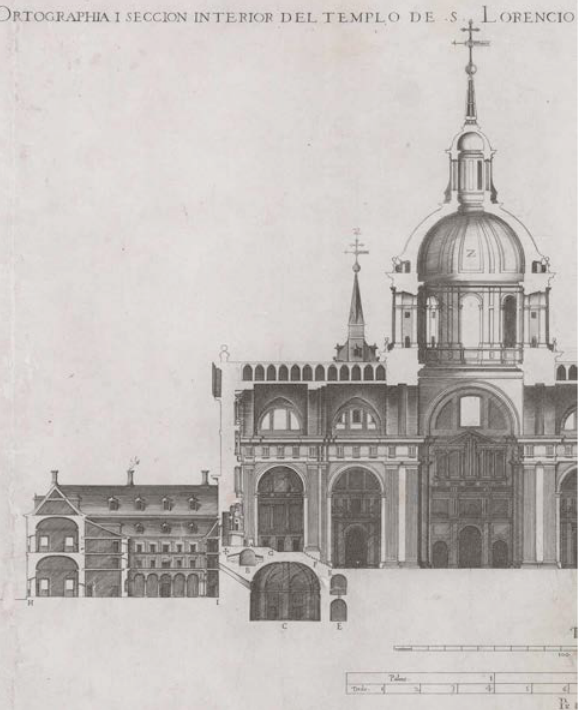
Figure 2. Herrera and Perret, 1587: longitudinal cut of the Monastery showing the Royal Pantheon (detail).